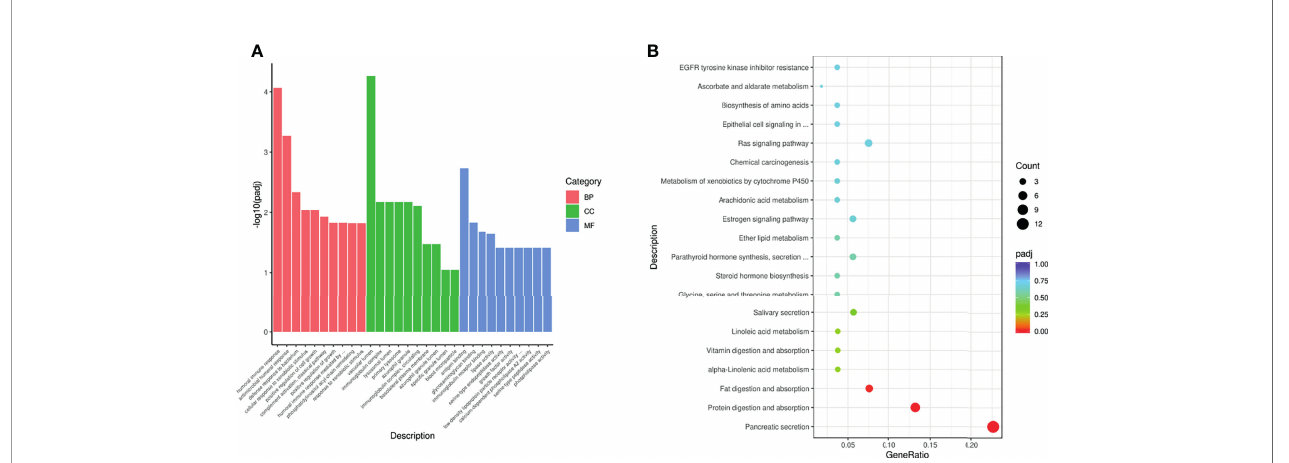
FIGURE 3 | GO (A) and KEGG (B) enrichment analysis of DEGs between the RCC and